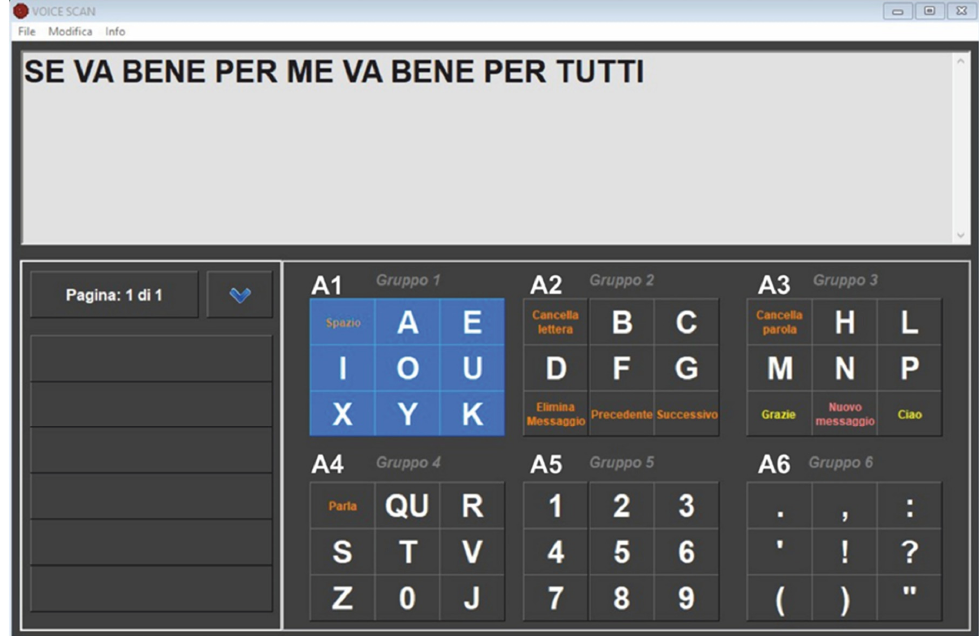
Figure 2. Lisa writes her opinion on her new AAC. The computer writes in response to Lisa’s commands with her left thumb click. Lisa cannot see the scanning marker, she can only hear the corresponding code: “A1” for group 1 (‘gruppo’ means group in Italian), “A2” for group 2, and so on. After the first click (group selection) by pressing the control switch, she hears the letters of the selected set, spelt out one after another (e.g., A-E-I-O-U-J-X-Y). A second click chooses the desired letter. This screenshot shows one of the first sentences written by Lisa (translated from Italian “If it works for me, it works for everyone”), who motivated this present article.